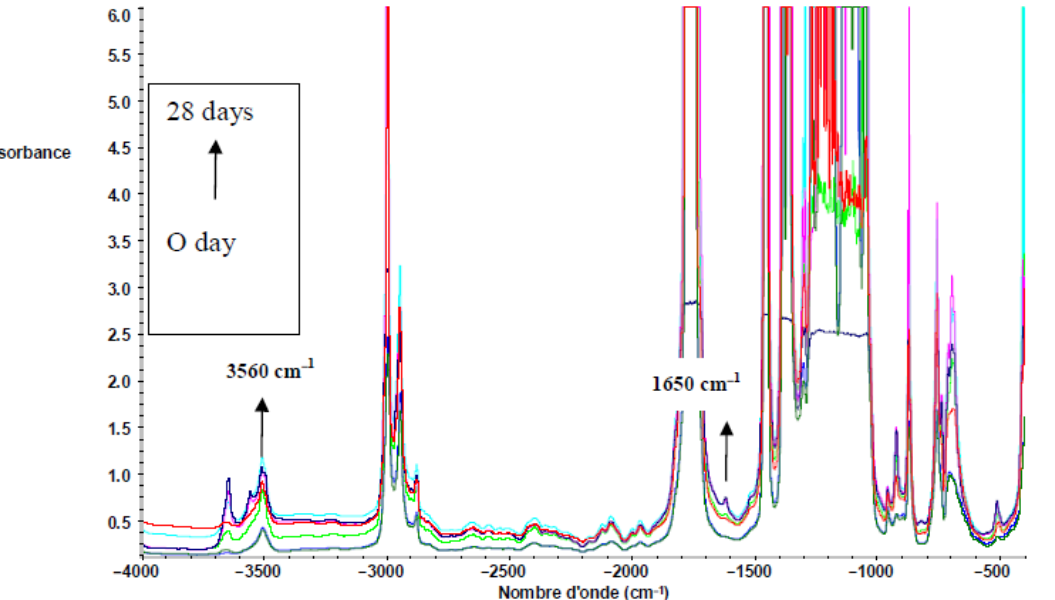
Figure 6. FTIR spectra of PLLA films during composting (0 until to 28 days) in the region of 4000 − 400 cm − 1 .